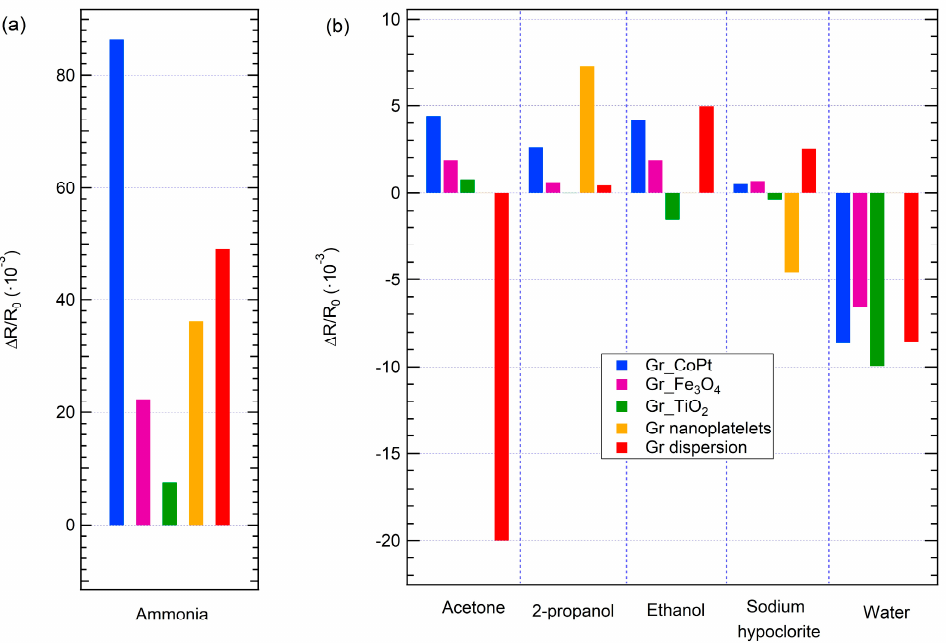
Figure 4. Response of the sensor array to selected target molecules: ( a ) ammonia; ( b ) acetone, 2‐propanol, ethanol, sodium hypochlorite, and water.